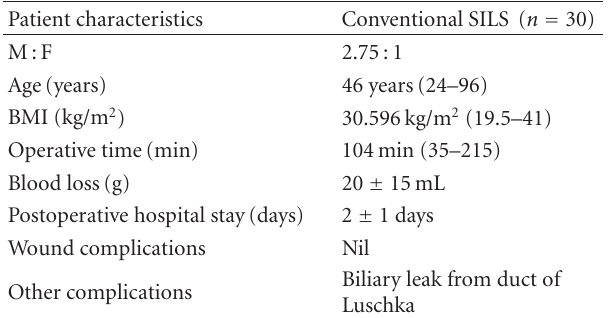
Table 1: Summary of patient characteristics.